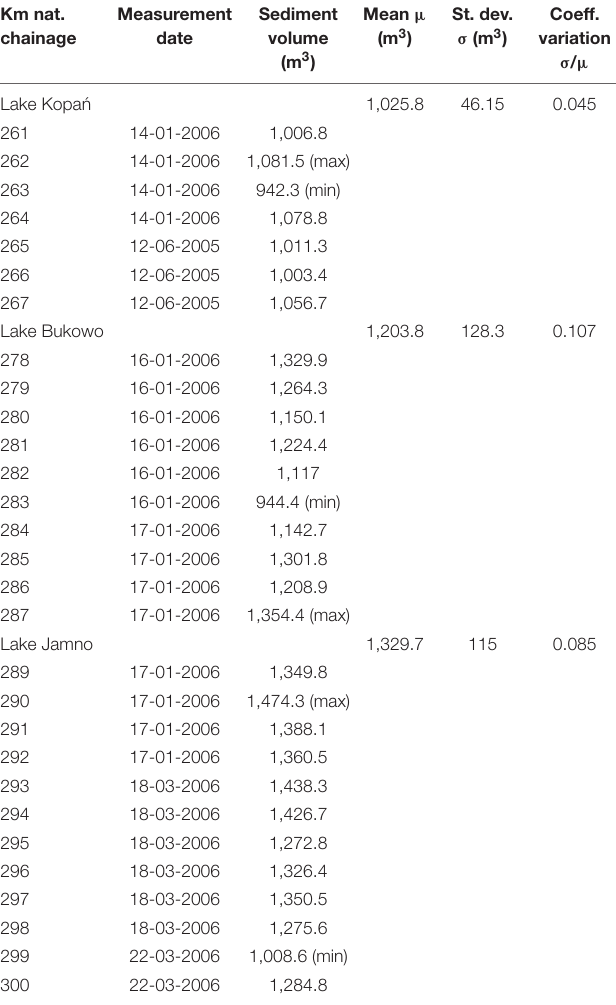
TABLE 2 | Sediment volumes between + 2 and − 6 m ordinates based on seabed survey of 2005-6. Km nat.